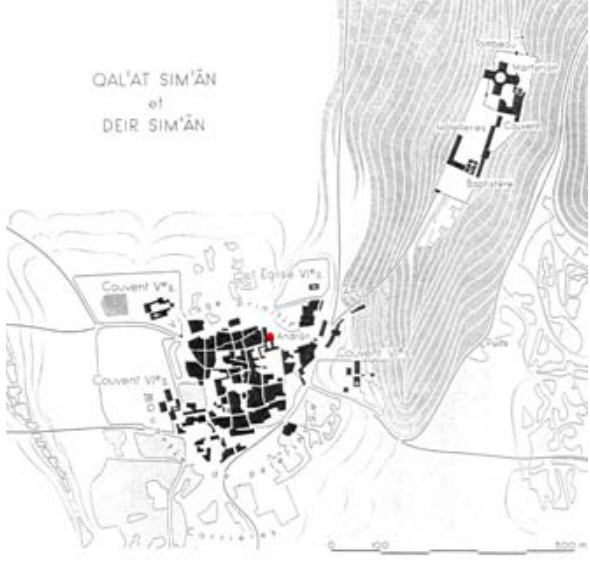
Figure 16. Plan of the site (Tchalenko,